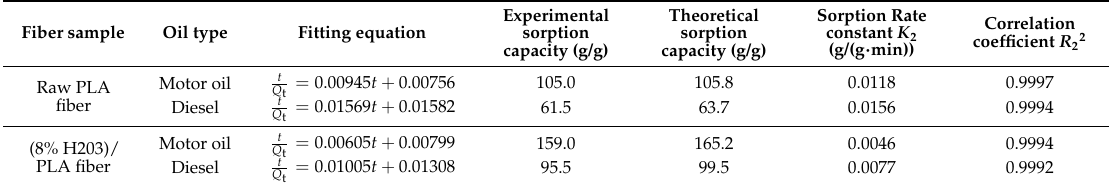
Table 4. Parameters of oil sorption kinetics of the second-order kinetic law of the Lagergren model.